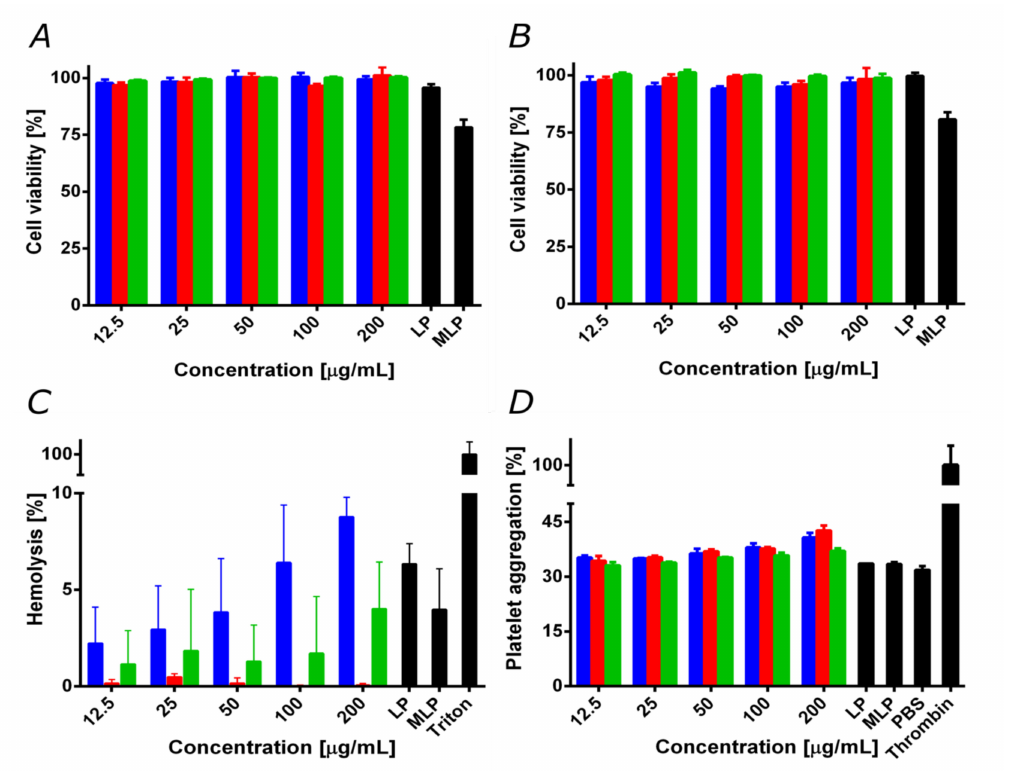
Figure 6. Biocompatibility assays for magnetite / silver (blue), magnetite / silver-pDMAEMA (red) and magnetite / silver-pDMAEMA-PEA-BUFII (green). LP represents free liposomes and MLP magnetoliposomes. ( A ) Cytotoxicity by LDH in Vero cells line after 24 h. ( B ) Cytotoxicity by LDH in Vero cells after 48 h. Except for MLP, cell viability remained above 95%. ( C ) The hemolysis assay shows an average hemolytic e ff ect below 9% in all cases. The positive control was Triton 100-X. ( D